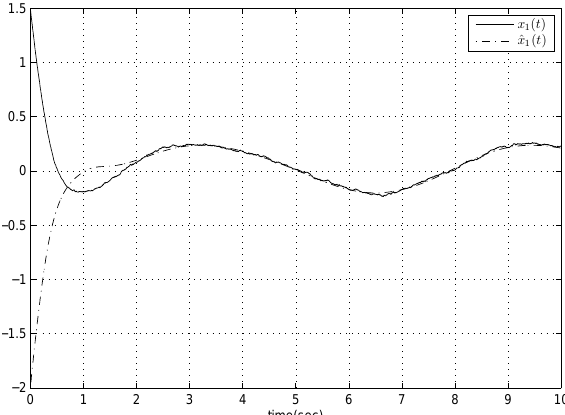
Fig. 2. Responses of the state x 1 ( t ) and its estimation b x 1 ( t )